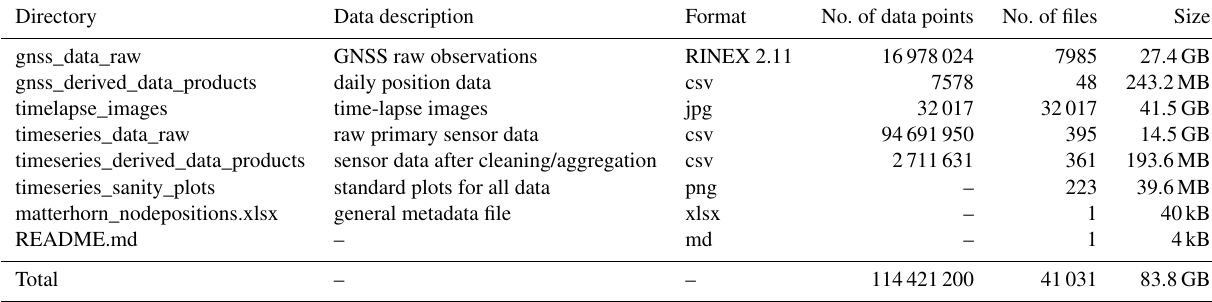
Table 6. Structure, description, formats and sizes of the data set